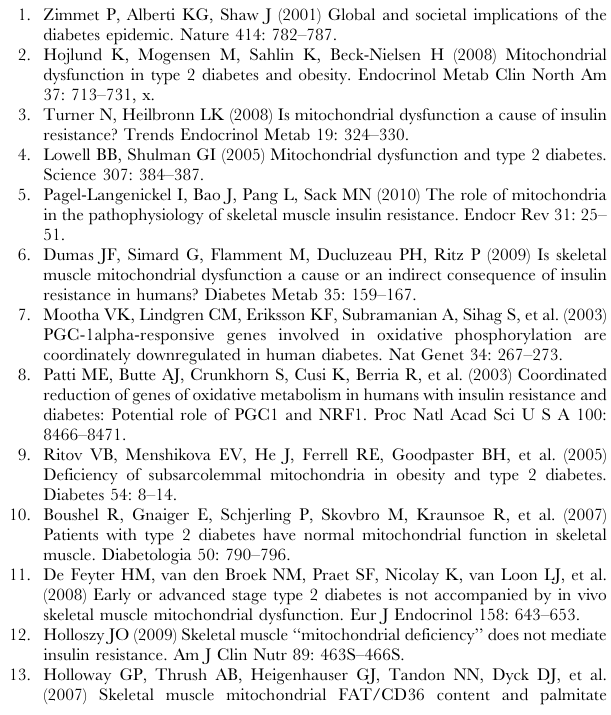
Table S1 A complete list of the 293 distinct ATP-ABP -labeled proteins identified by LC-MS analysis. Table S2 A complete list of proteins and assigned annotations by Ingenuity Pathway